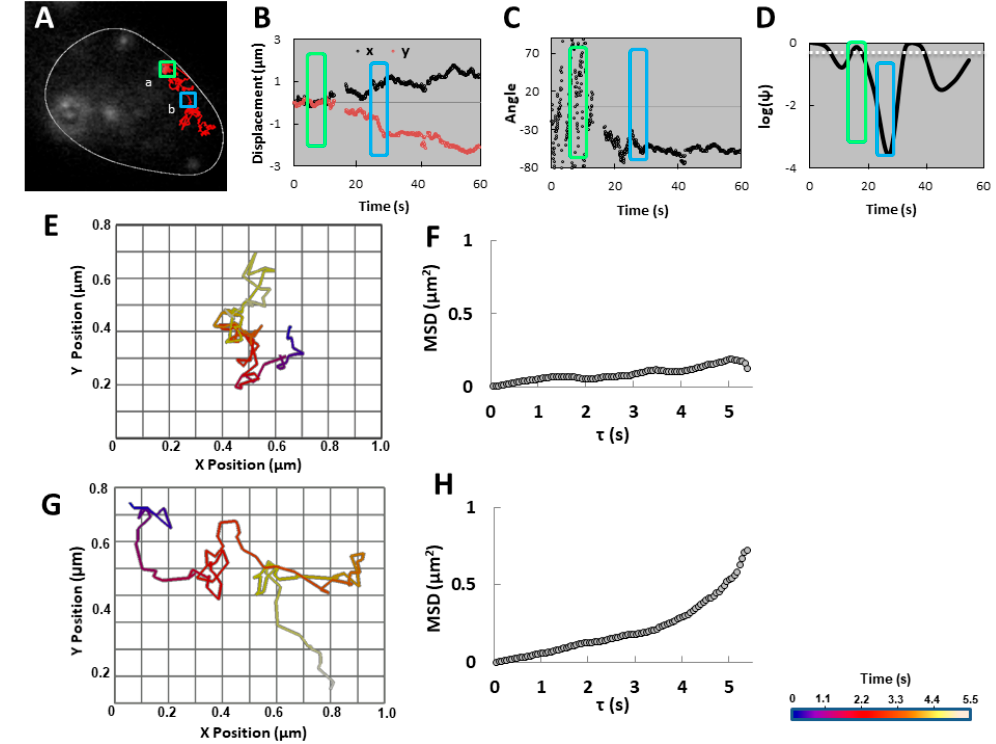
Figure 6. Transitions in type of movement were observed in the same track. ( A ) Two sections of the track for the granule in Figure 5A, marked by the green and blue squares, were analyzed further in 2D in panels ( B – F ). ( B ) Granule displacements on the x- and y- axes as a function of time were minimal at first (green box), but then increased in magnitude over time (blue box). ( C ) Angle of the movement relative to its position at the start of the observation period as a function of time was initially random (green box), then turned several times (e.g., blue box), before settling on a particular directionality. ( D ) Log( ψ ) of the track was calculated in segments of 100 frames as a function of the time. The white dashed line represents the Log( ψ ) threshold = − 0.3 Log( ψ ) falling below the threshold was indicative of directed motion. ( E , G ) Vantage visualizations are shown for the track segments marked by the green and blue boxes in ( A ), respectively. The color scale refers to di ff erent time periods lasting 5.5 s in these two panels only. ( F , H ) MSD parameter was calculated for the track segments marked by the green and blue boxes in ( A ),